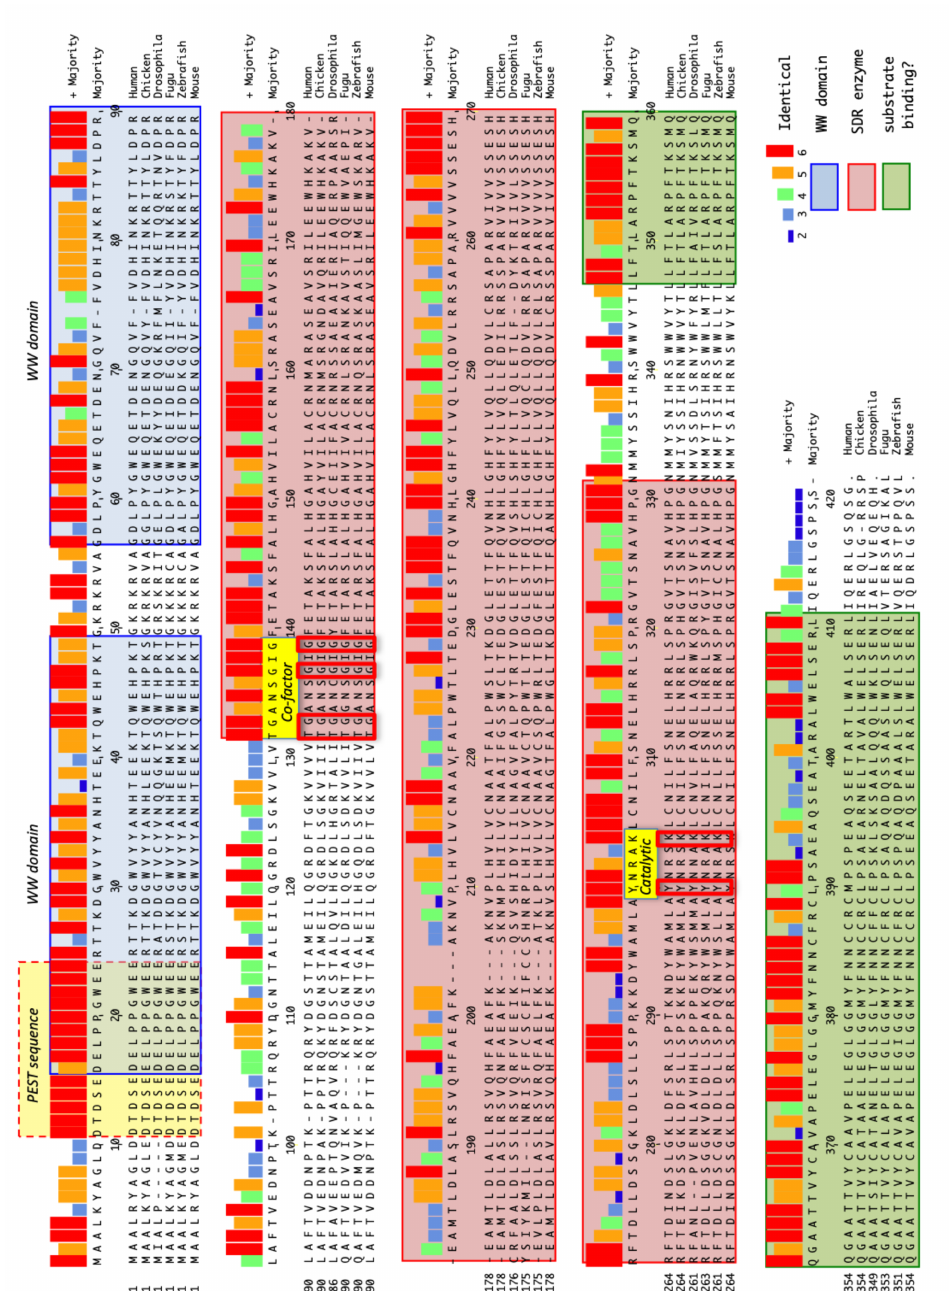
Figure 2. Homology between WWOX proteins of different species—Human, Chicken, Drosophila , Fugu , Zebrafish, Mouse. In addition to WW domains and SDR canonical sequences, the putative substrate specificity sequences are indicated (green shading). Not shown but noted, the WWOX orthologue in the evolutionarily distant sea sponge ( Amphimedon queenslandica ) has WW domains and also has substrate binding domain homology. Furthermore, also not shown but noted, the closest SDR family members in the Opisthokonts ( Casaspora owczarzaki ) and Caenorhabditis elegans (NP_503155.4 and NP_495501.1) do not have WW domains but do have homology in the putative substrate specificity domain. Highly conserved PEST sequence domain (with 14 of 15 amino acids identical) and the cofactor and catalytic sites that are typical of SDR enzymes are indicated (yellow